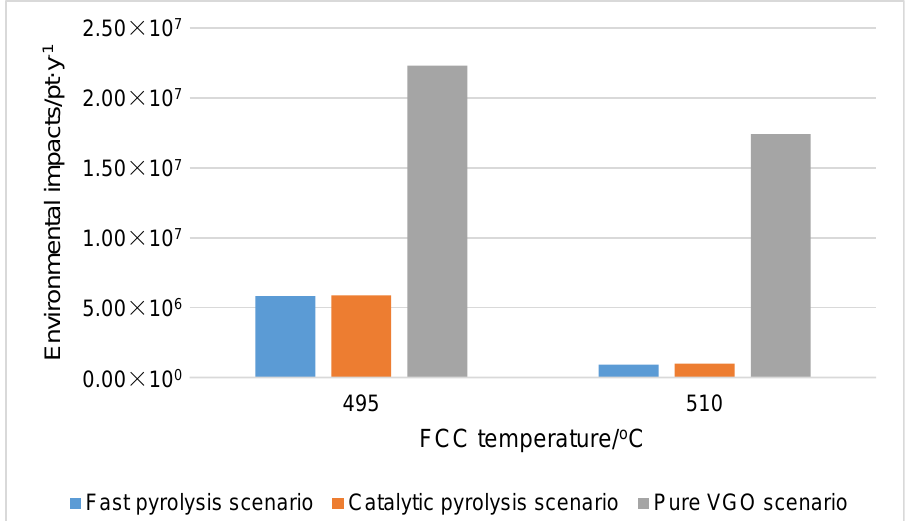
Figure 7. Effect of FCC feed density on environmental impacts.